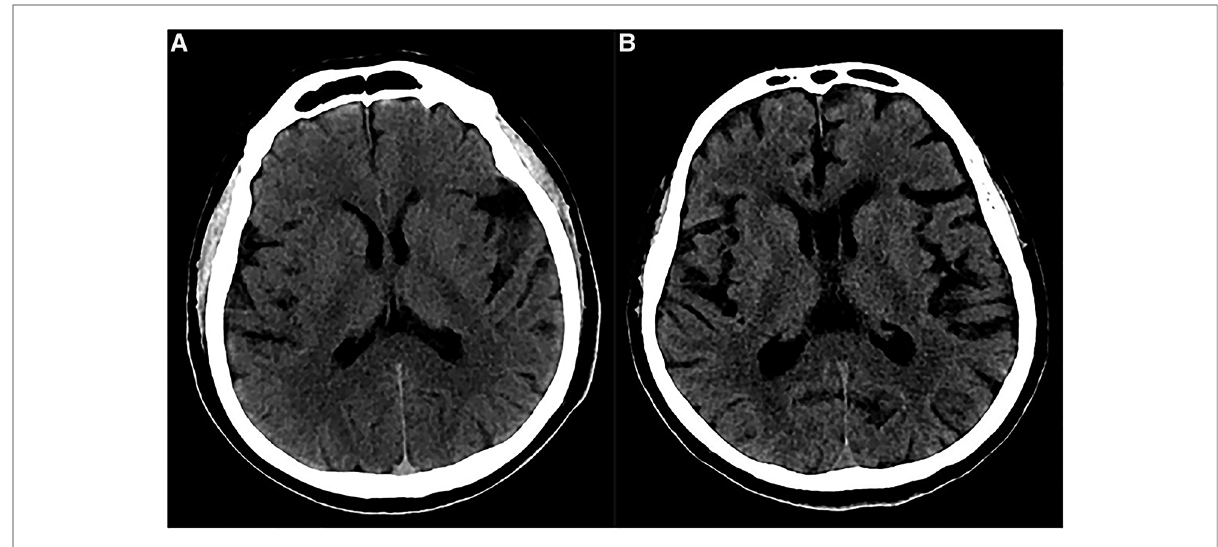
FIGURE 6 Preoperative imaging of patients with cerebral atrophy. ( A ) Preoperative CT showed a slight widened Sylvian fi ssure. ( B ) Preoperative CT showed more obvious widened cerebral sulcus and fi ssures as compared to